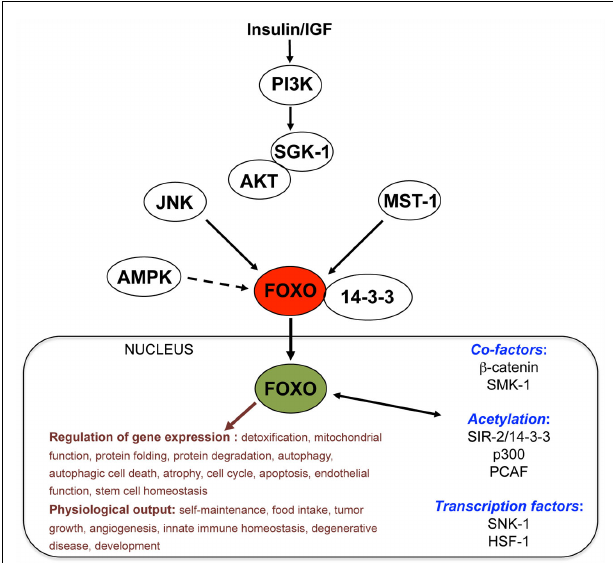
FIGURE 1 | Simplified view of the FOXO network. This diagram shows signaling pathways well-established (straight arrows) or hypothesized (dashed arrow) to converge onto FOXO.The list of target gene classes and physiological outputs is not